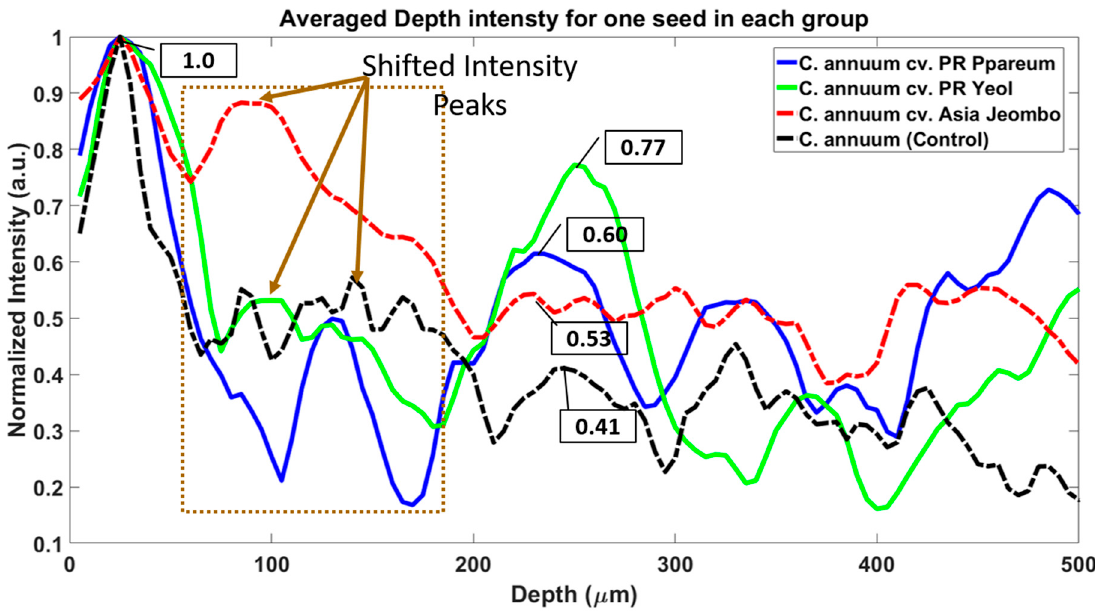
Figure 7. Averaged and normalized depth intensity plots of one seed in all four seed groups. The averaging window was set to 10 for all